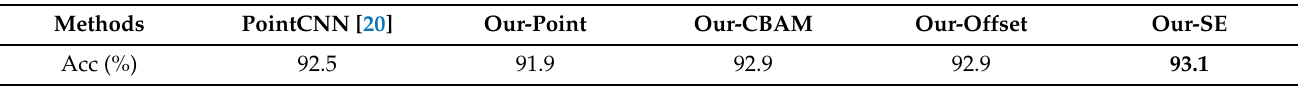
Table 6. Comparison of classification accuracy on ModelNet40 (1024 points), where PointCNN [20] classification accuracy is taken from the results of that paper.